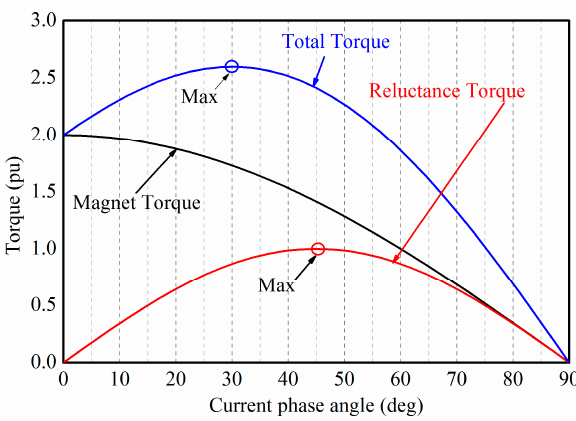
Figure 10. Torque behaviors with constant L d and L q .